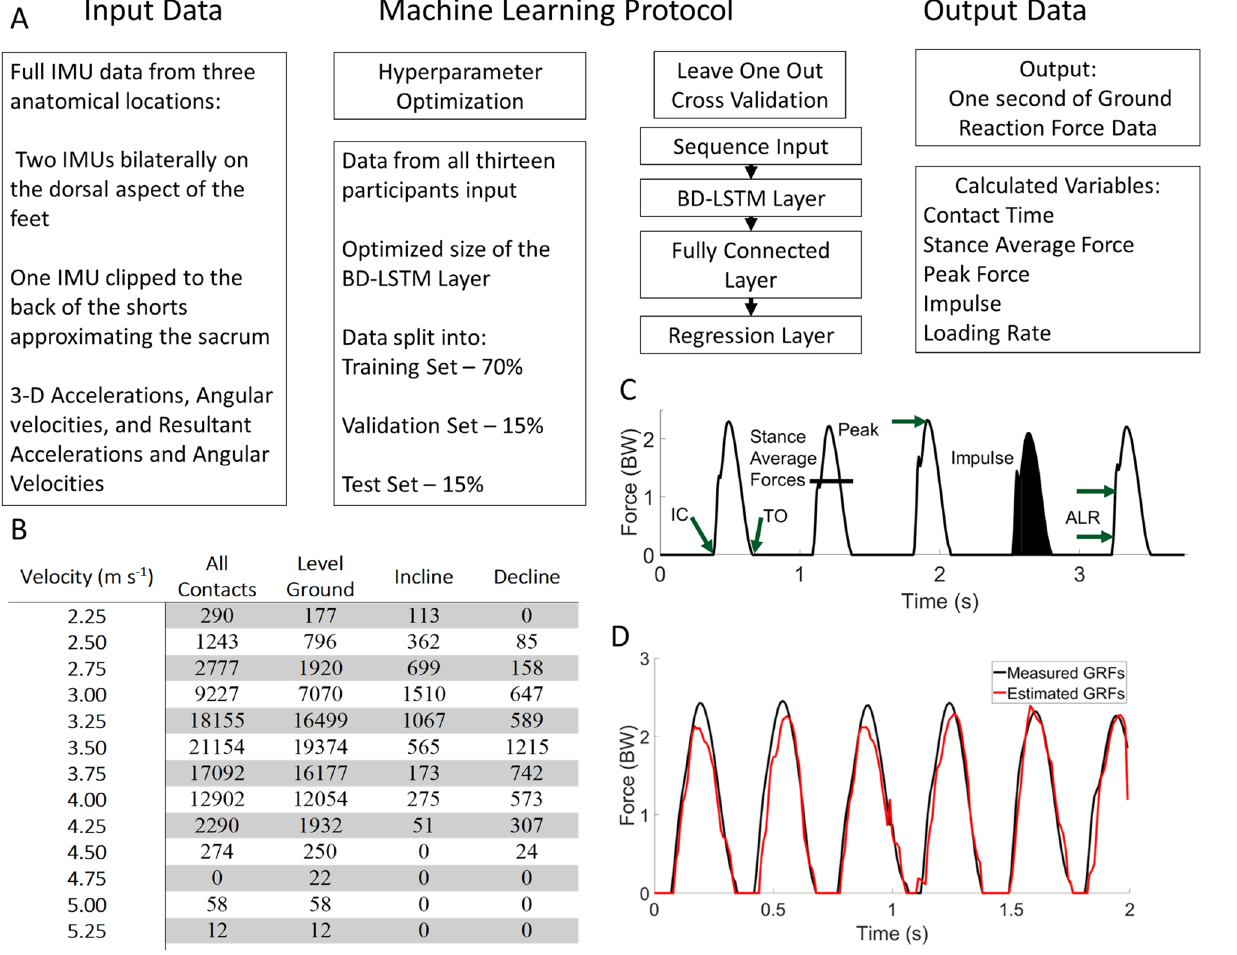
Figure 10. Outline of the machine learning protocol in Panel ( A ). The number of steps in each velocity and grade are presented in Panel ( B ). In panel ( C ), the temporal and kinetic variables calculated from both the measured and estimated waveforms. Panel ( D ) shows data from two separate one second windows which were